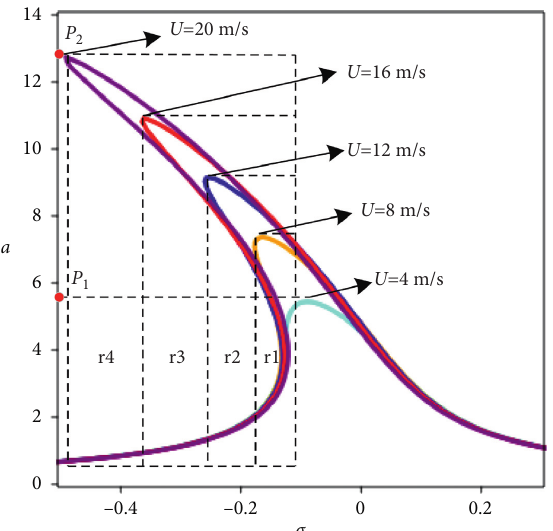
Figure 7: The amplitude-frequency response curve of primary resonance (varied U ).